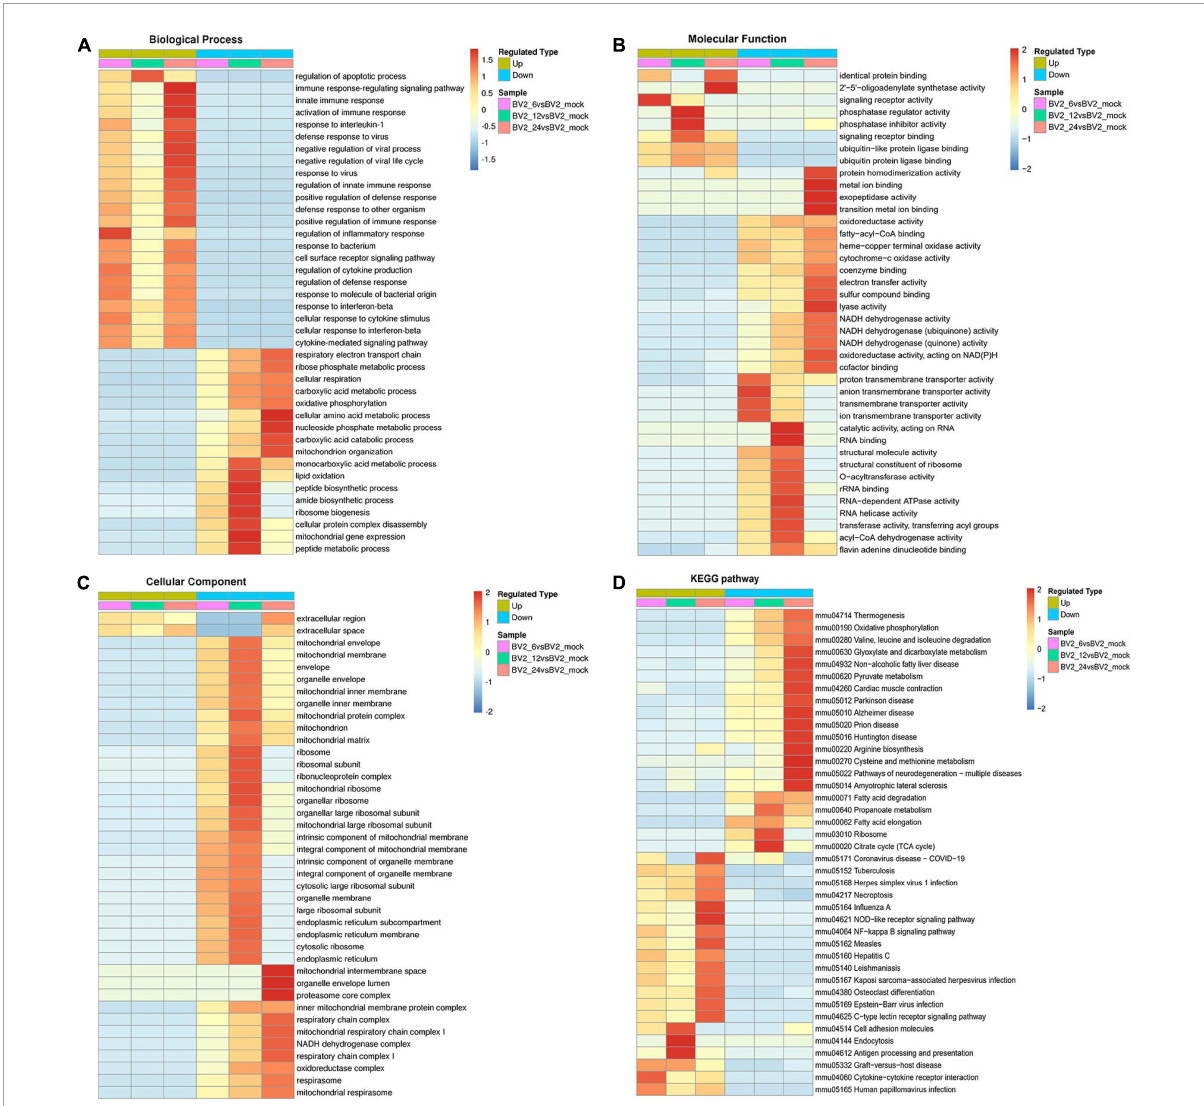
FIGURE2 Functional enrichment of DEPs in BV2 cells after JEV infection. (A–C) Heat map of cluster analysis based on GO enrichment. (A) Biological process showing activation of multiple immune responses, indicating activation of cellular immune responses after JEV infection. (B) Molecular function showing activation associated with protein binding, suggesting that the cascade effect of the immune response is also activated. (C) The cellular component was enriched for fewer upregulated proteins and a larger number of proteins with decreased expression, thus indicating that intracellular component expression was suppressed by JEV infection. (D) Heat map of clustering analysis for KEGG enrichment. Infectious disease pathways were activated, while the expression of proteins related to autoimmune disease-related pathways was decreased. Cell adhesion molecules, along with antigen processing and presentation pathways, were highly enriched at 12 h. All enriched proteins were significantly different, with a red to blue gradient indicating higher to lower protein